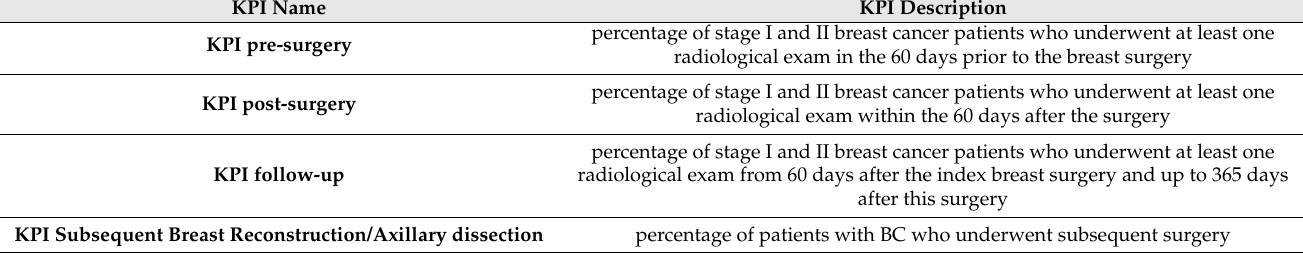
Table 3. KPIs description.